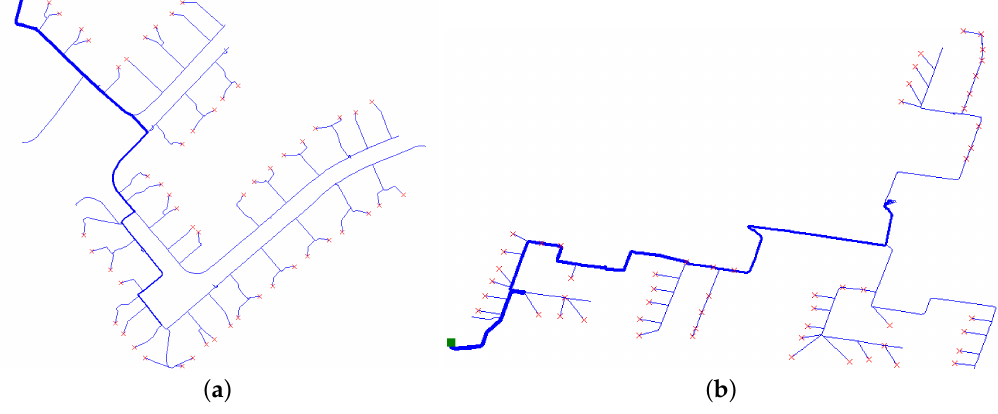
Figure 4. Sample Open Distribution System Simulator (OpenDSS) power flow plots of the used power networks. Consumers are indicated as red crosses and 11/0.416-kV substations are marked with a green square. ( a ) IEEE Power and Energy Society (PES) EU Low Voltage Test Feeder plot; ( b ) Scottish and Southern Energy Power Distribution (SSE-PD) Common Information Model (CIM) (UK) feeder